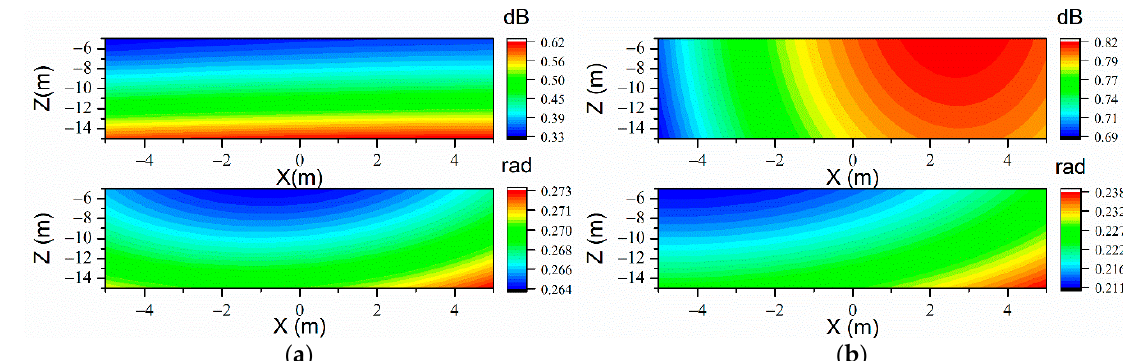
Figure 11. The sound prediction errors of CMESM on the prediction plane when 135 uniformly arranged measurement points are used at the frequency of 71 Hz. ( a ) Free field ( L 1 = 92, upper: p E ; lower: ϕ E ) and ( b ) h U = 0.2 m ( L 1 = 95, upper: p E ; lower: ϕ E ).